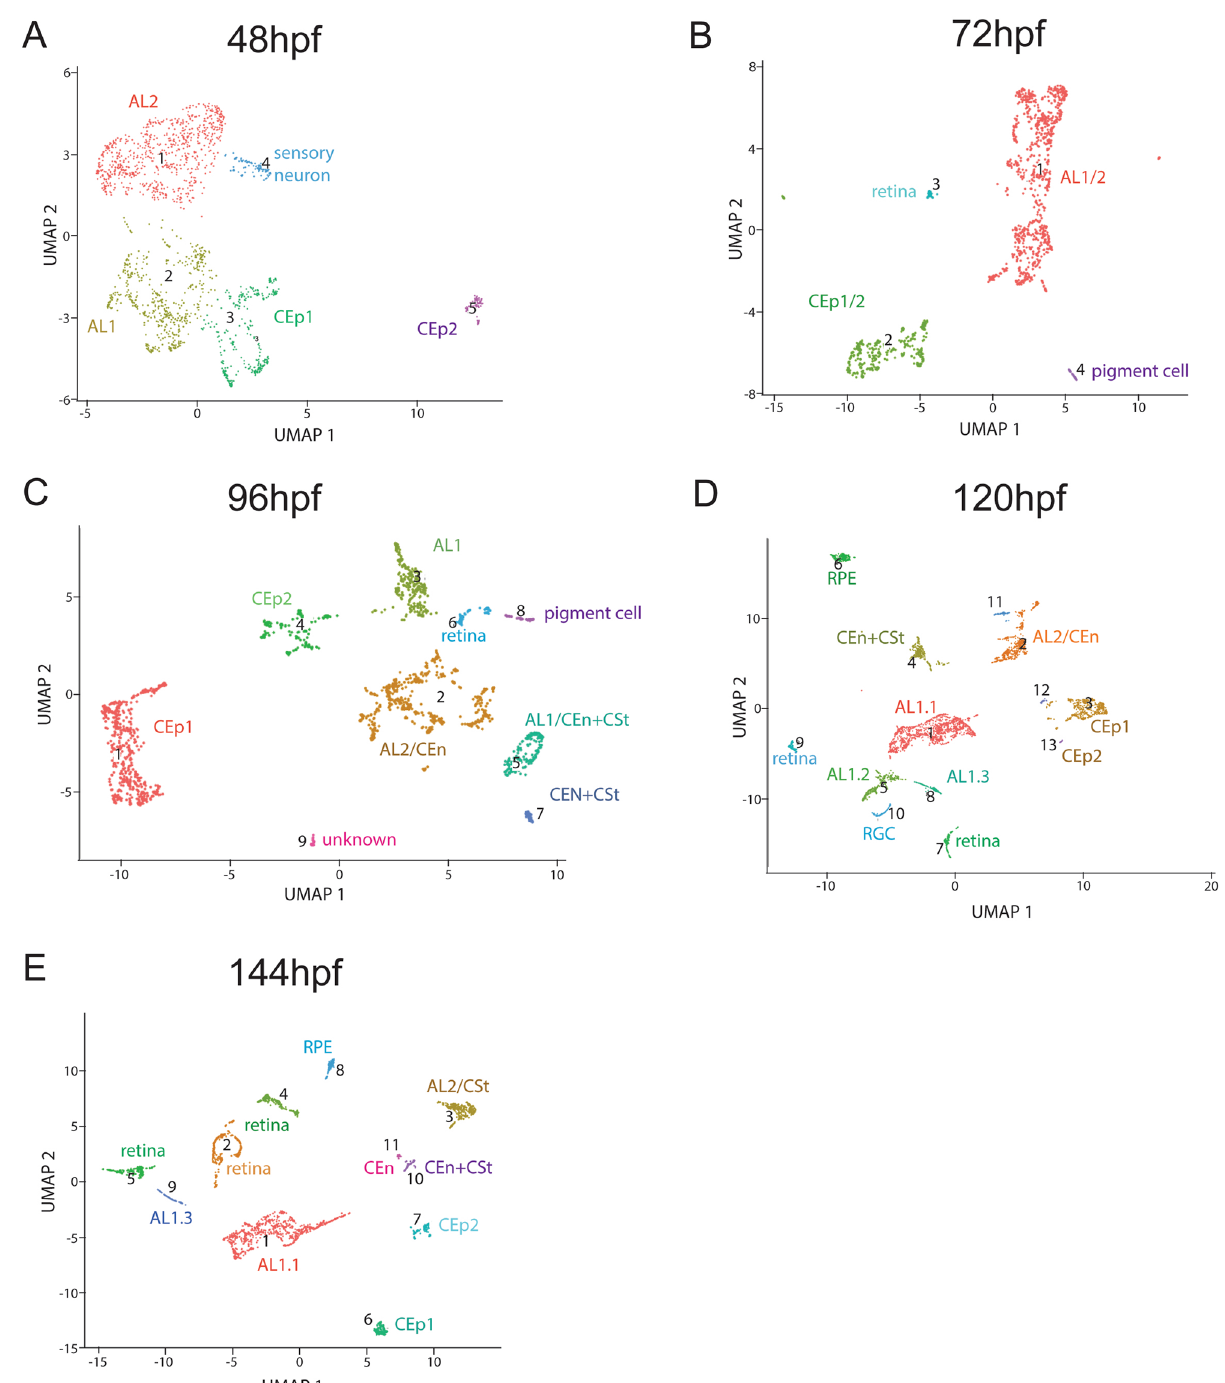
Figure 3. Clustering of purified ASM throughout early AS development. Cluster numbers are indicated in brackets. ( A ) Cluster distribution at 48 hpf. The five clusters observed were identified as: CEp1(2), CEp2(5), AL1(1), AL2(3) and sensory neurons(4). ( B ) Cluster distribution at 72 hpf. The four clusters observed were identified as: AL, CEp, retina and pigment cells. ( C ) Cluster distribution at 96 hpf. The nine clusters observed were identified as: CEp1(1), AL2/CEn(2), AL1(3), CEp2(4), AL1/CEn + CSt(5), retina(6), AL1/CEn + CSt(7), pigment cell(8), unknown(9). ( D ) Cluster distribution at 120 hpf. The fifteen clusters observed were identified as: AL1.1(1), AL2/CSt(2), CEp1(3), AL1/CEn + CSt(4), AL1.2(5), unknown(6), retina(7), AL1.3(8), retina(9), RGC(10), unknown(11). unknown(12), CEp2(13), unknown(14), unknown(15). ( E ) Cluster distribution at 144 hpf. The twelve clusters observed were identified as: AL1.1(1), retina(2), AL2/CEn(3), retina(4), retina(5), CEp1(6), CEp2(7), RPE(8), AL1.3(9), AL1/CEn + CSt(10), CEn(11),